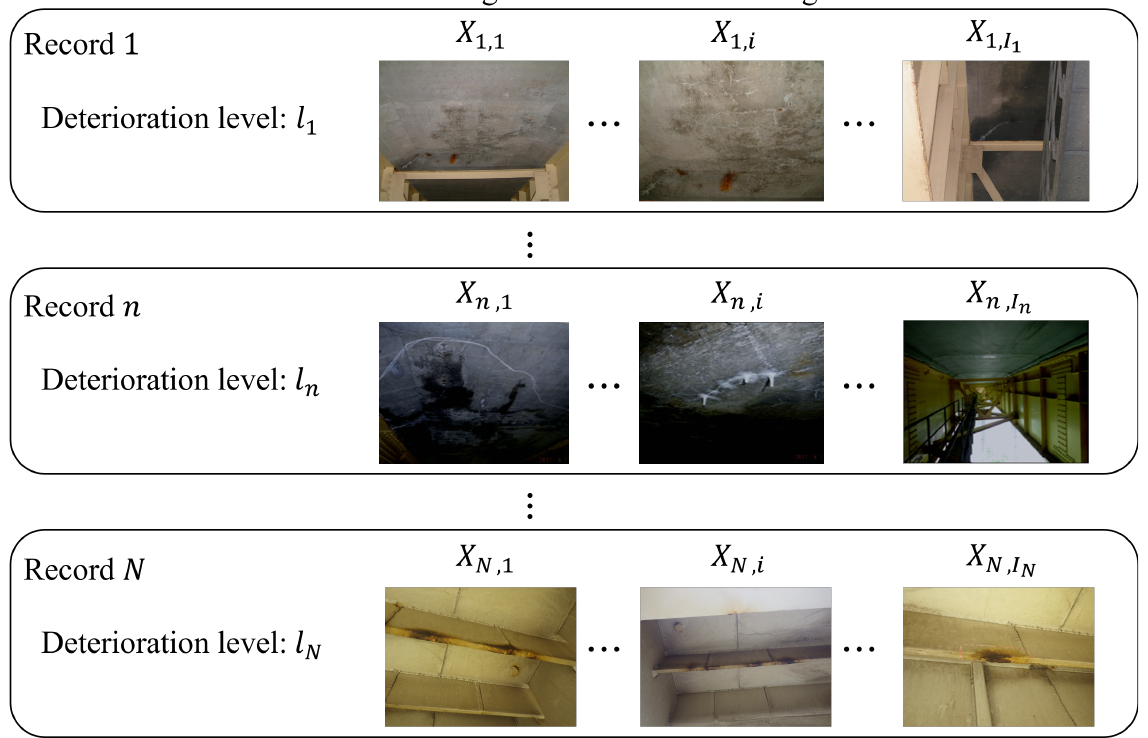
Figure 1. Examples of multi-view distress images taken by engineers at the practical inspection.